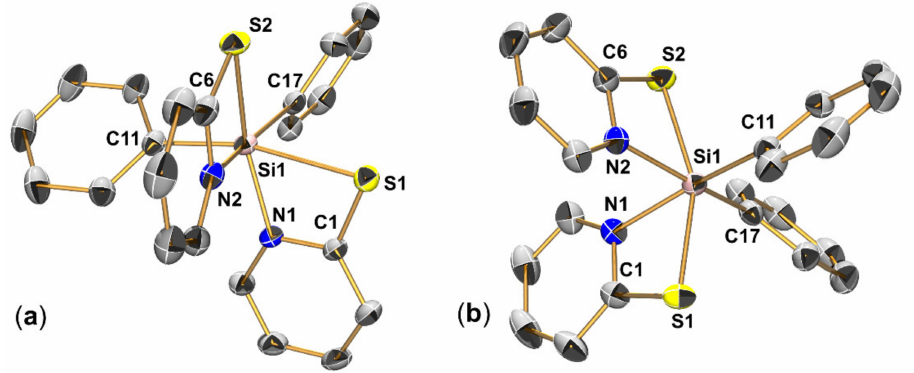
Figure 11. Molecular structures of isomers of Ph 2 Si(pyS) 2 ( 3b ): ( a ) isomer 3b 1 and ( b ) isomer 3b 2 (in modification 1, space group P 2 1 / n ) in the crystal with thermal displacement ellipsoids at the 50% probability level and selected atom labels. For the sake of clarity, the H atoms are omitted from the graphic. Selected interatomic distances (Å) and angles (degrees) of 3b 1 : Si1-S1 2.5683(5), Si1-S2 2.3335(5), Si1-N1 1.9058(11), Si1-N2 1.9694(12), Si1-C11 1.9181(14), Si1-C17 1.9162(14), S1-Si1- S2 91.868(18), N1-Si1-N2 90.00(5), C11-Si1-C17 101.37(6), S1-Si1-C11 165.91(5), S2-Si1-N1